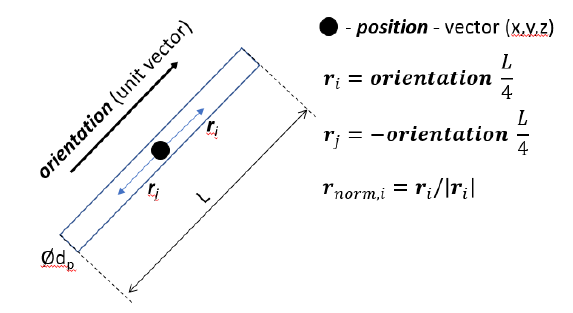
Fig. 1. Fibre description